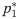
Contour plot of the convergence time t* in Eq (6) as a function of p1* and p2*, where p1*+p1*≤1, when (A) α = 0.25, (B) α = 1, and (C) α = 5.When α = 1, the contribution of each individual is proportional to his/her participation load. When α = 0.25, the individuals can decrease their participation load and keep the same convergence time as long as both individuals share the participate load during the process of task completion. The opposite situation occurs when α = 5, where the convergence rate will increase if both individuals decide to participate and share the participation load.